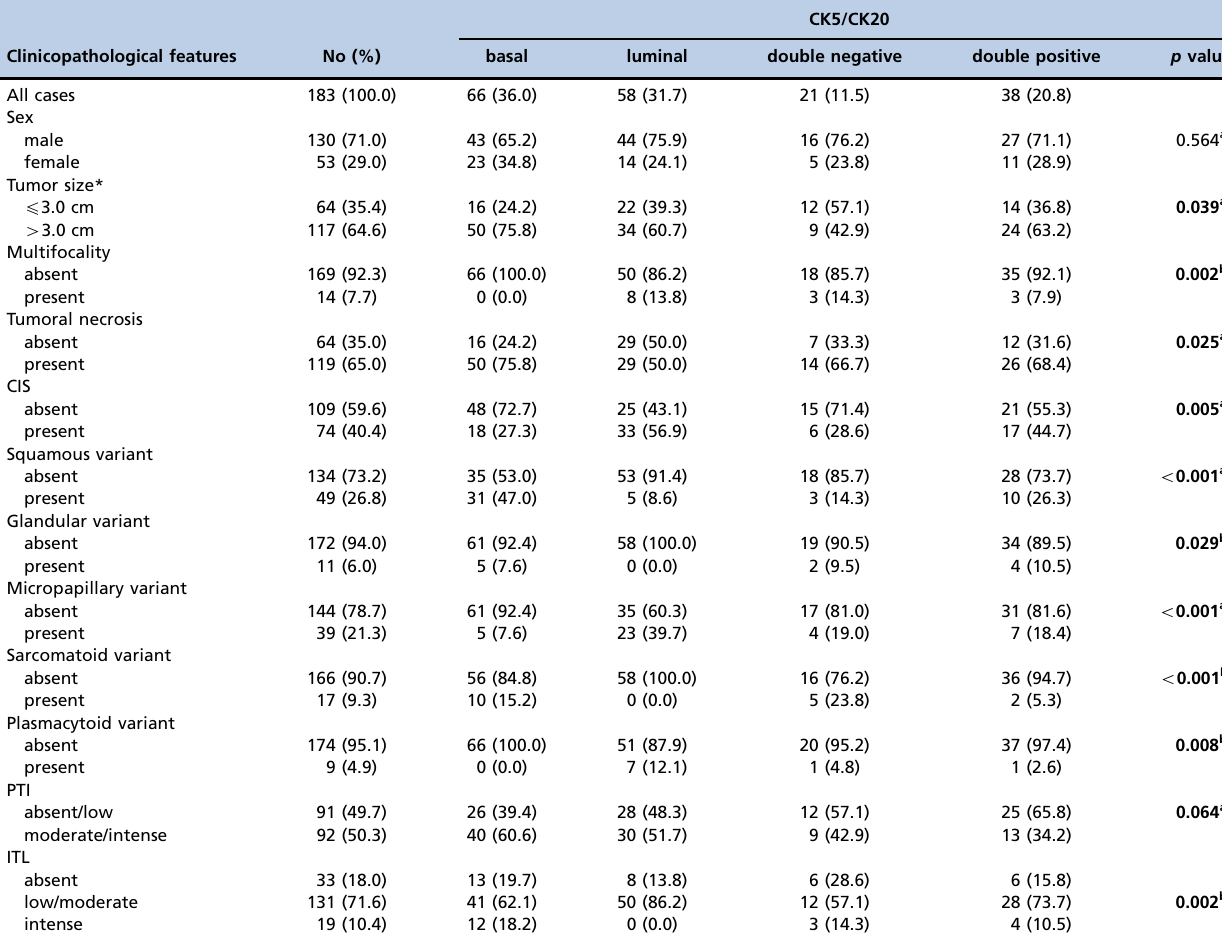
Table 2 - Associations between IHC MIUCB subtypes and clinicopathological features obtained using CK5 and